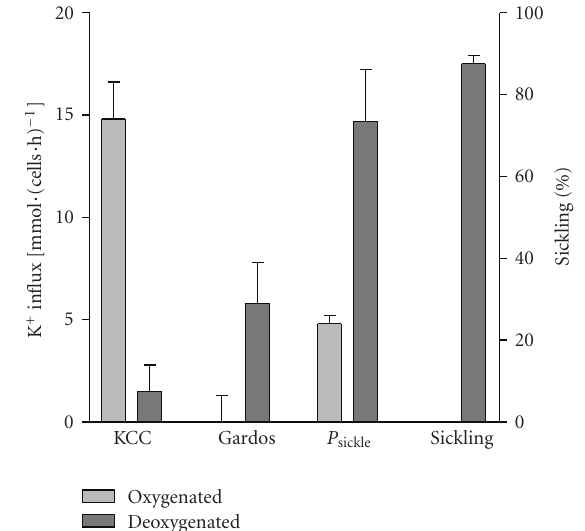
Figure 3: Components of K + transport pathways and sickling in red blood cells (RBCs) from sickle cell disease patients heterozygous for HbS and HbC (HbSC genotype). K + influxes are given as flux units [mmol · (l cells · h) − 1 ] measured at 5 mM [K + ] o and numbers of sickled cells as a percentage of total RBCs in fully oxygenated (150mmHg O 2 ) or deoxygenated (0mmHg) conditions. Although this technique measures a K + influx, because of the high K + content of RBCs, net solute movement through the transport systems will be outwards. KCl cotransport activity was calculated as the Cl − - dependent K + influx, Gardos channel activity as the clotrimazole (5 μ M)-sensitive K + influx, and P sickle as the Cl − -independent K + influx (Cl − substituted with NO 3 − ). Sickling, P sickle , and Gardos channel activation occurs in deoxygenated conditions—as for HbSS RBCs—but KCC activity is low when O 2 is removed (as in RBCs from HbAA cells). Data taken from